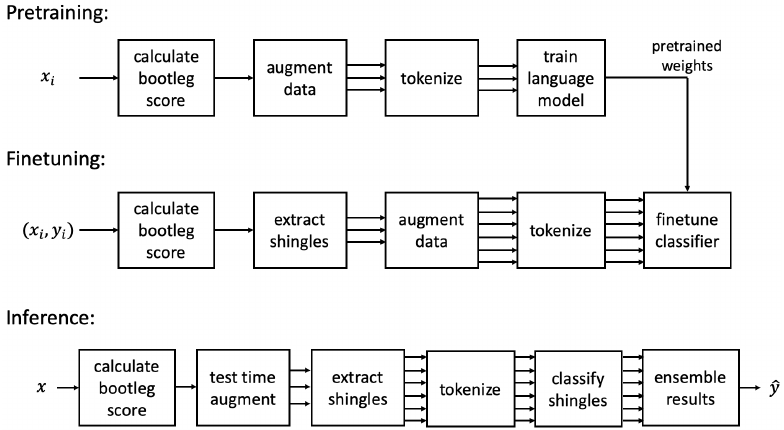
Figure 1. Overview of approach to composer style classification of sheet music images. The input x is a raw sheet music image, and the label y indicates the